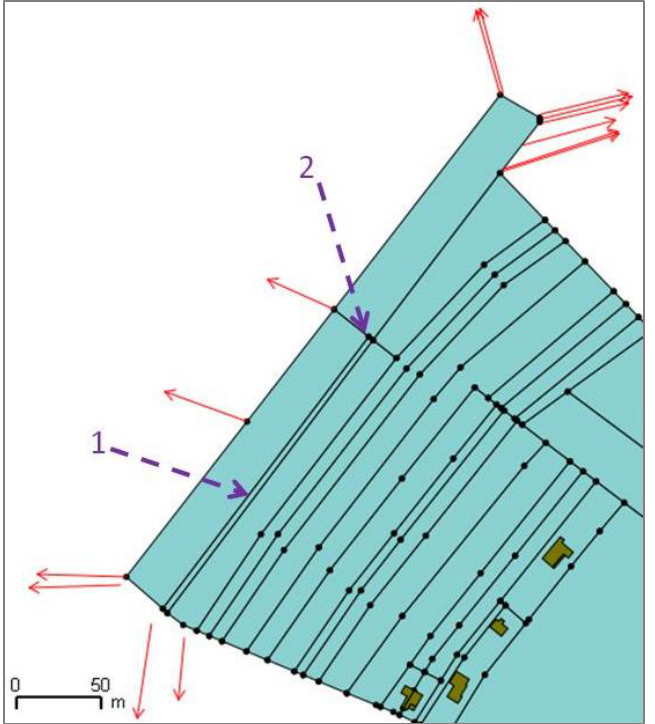
Figure 22. Initial data to conflate where the identified two defects (very long ( 1 ) and very short ( 2 ) segments with large distortions) may